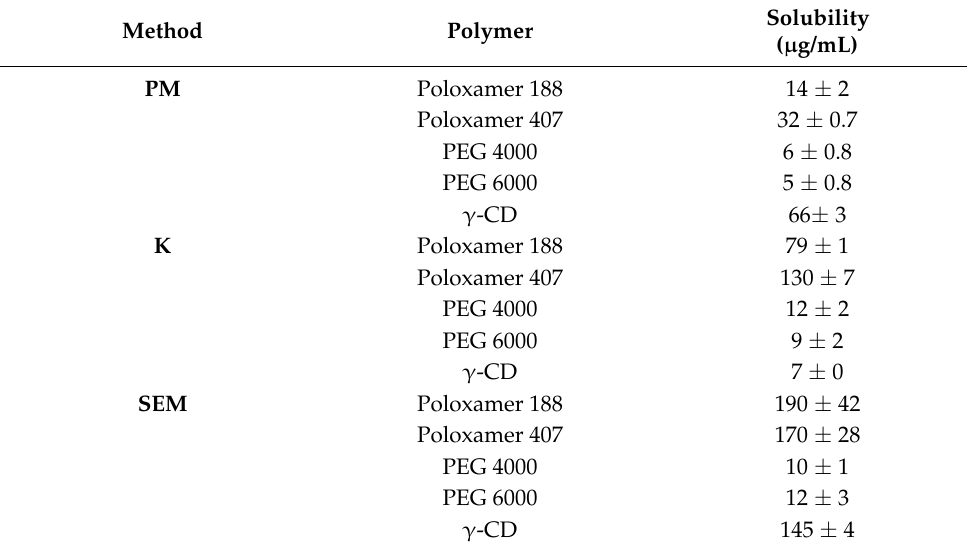
Table 2. Solubility of OA in hydrophilic polymers, using 1:2 drug-to-polymer weight ratio and differ- ent preparation methods (PM: physical mixture; K: kneading; SEM: solvent evaporation